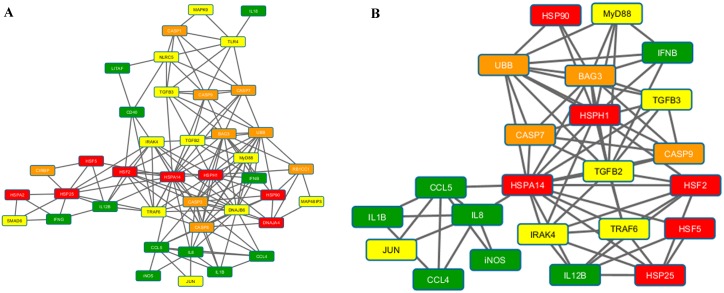
Spearman correlation network for samples treated with LPS at time point 2h.(A) The complete network showing interaction between genes at 0 hours after LPS treatment. Highly connected hubs includes TLR4, IFNB, MyD88, IL8, and HSPA14. (B) Cluster 1 from MCODE network clustering algorithm showing the interaction between IL8, IL1B, CCL5, CCL4, iNOS, JUN, and HSPA14 after ignoring the hairball to the right of HSPA14. The cluster shows interaction between immune response genes from LPS stimulation.